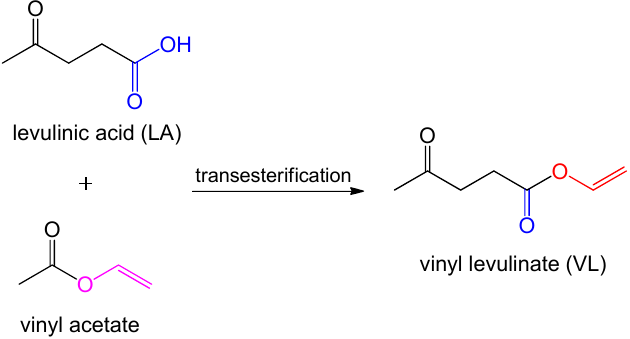
Figure 9. Synthesis of HEMA-DDSA from HEMA and DDSA [59].